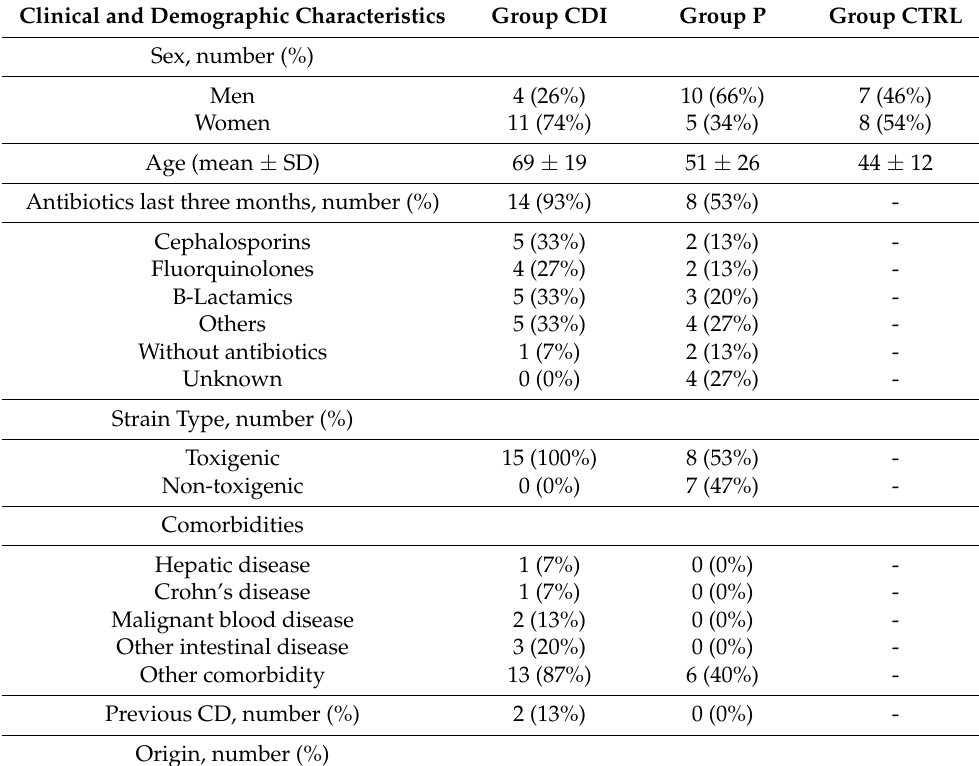
Table 1. Clinical and demographic characteristics of the study